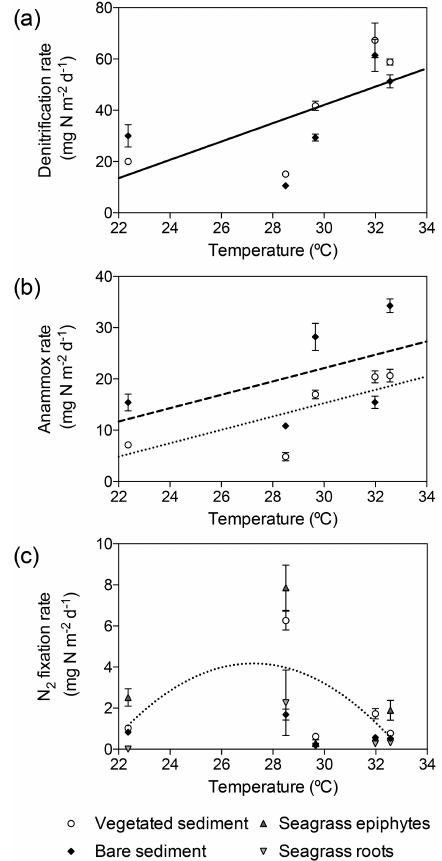
Figure 5. Relation of denitrification, anammox, and N 2 fixation rates to in situ seawater temperature. (a) Linear increase of denitri- fication rates (solid line) with temperature, showing denitrification rates in vegetated sediments (white dots) and bare sediments (black diamonds). (b) Linear increase of anammox rates in vegetated (dot- ted line and white dots) and bare (dashed line and black diamonds) sediments. (c) Thermal response of N 2 fixation rates in vegetated sediments (white dots), bare sediments (black diamonds), seagrass epiphytes (triangles) and roots (upside down triangles), showing the fitted second-degree polynomial curve in vegetated sediment (dot- ted line). Error bars indicate